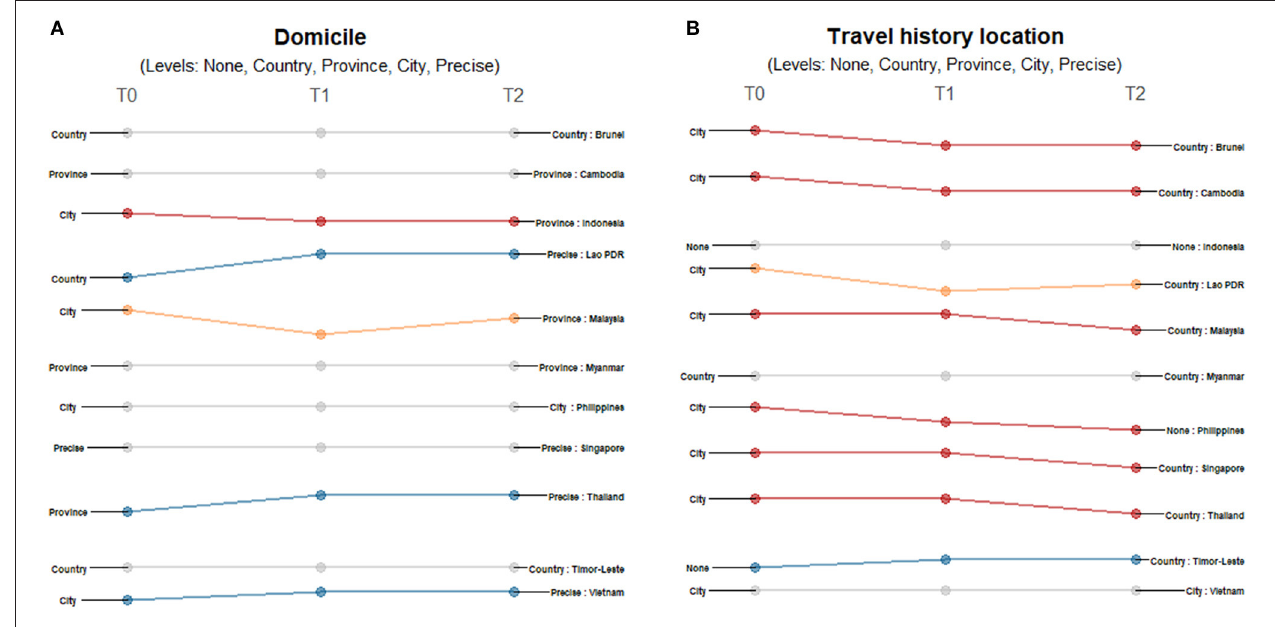
FIGURE 3 | Differences in the level of granularity in reporting geographic data: (A) domicile, and (B) travel history location over three timepoints. Only those countries with changes in the level of granularity or geographic resolution of reporting are highlighted. Each country may shift reporting at any timepoint: at the first reporting of cases’ (T0), “first observed change in reporting” (T1), and “last observed change in reporting” (T2). Each country may report less granular data indicated by a decreasing slope (red) or more granular data indicated by an increasing slope (blue) consistently over time. Reporting may not be consistent across timepoints with shifts between different levels of granularity (yellow) or reporting may not have changed at all during the study period (gray). The levels of granularity are indicated for each epidemiological variable. All geographic data have five levels of granularity/geographic resolution: none, country, province, city, and